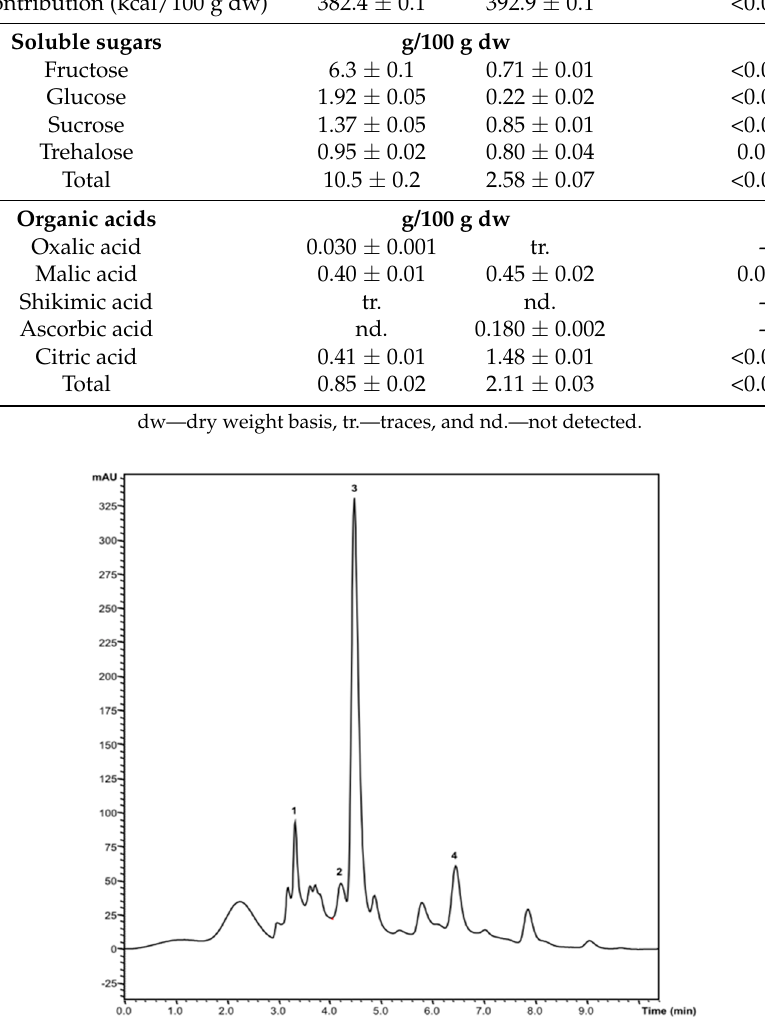
Figure 1. Organic acids chromatogram profile of the CH sample at 215 nm: 1—oxalic acid, 2—malic acid, 3—ascorbic acid, and 4—citric acid.